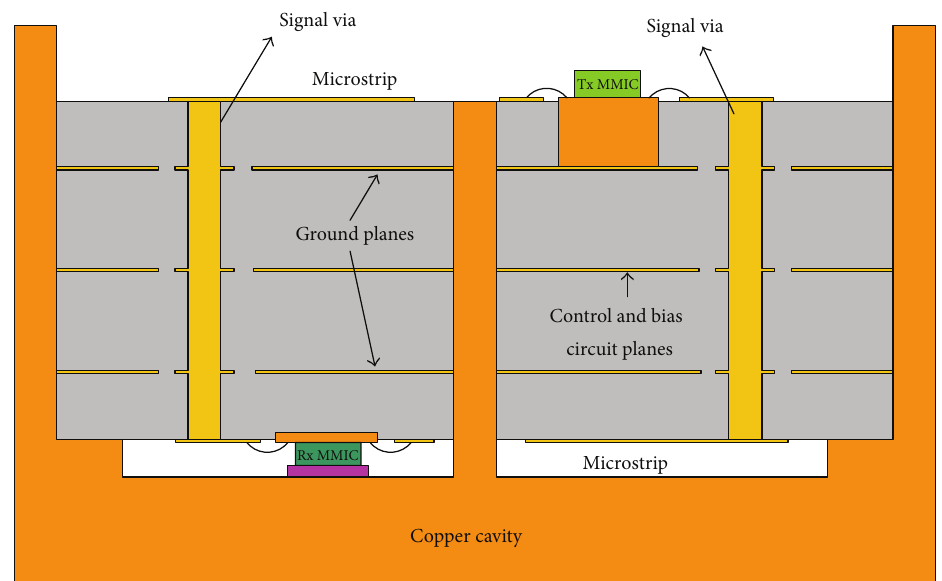
Figure 1: Side view of T/R module with vertical via transition.